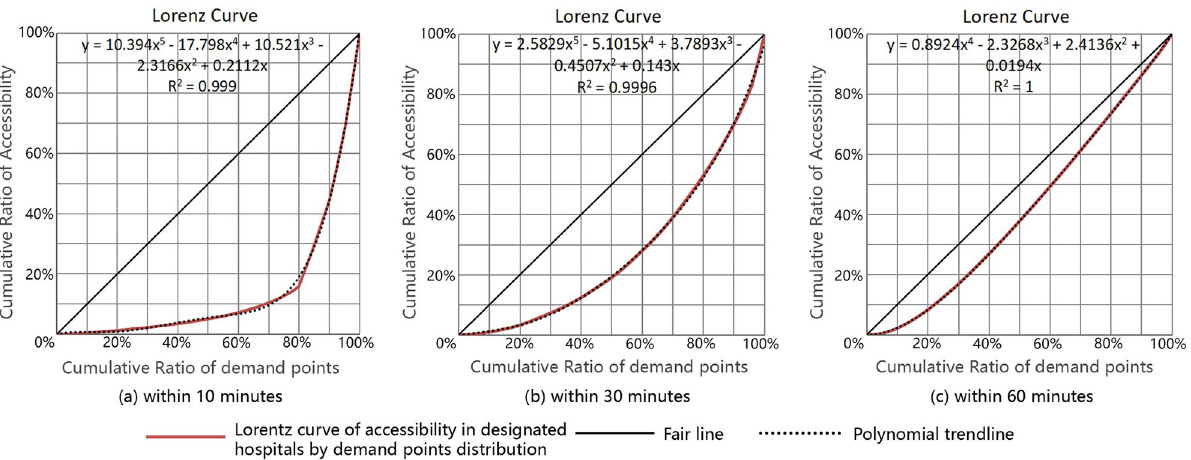
Fig 10. Lorentz curve of accessibility to designated hospitals by demand point distribution. (a)Within 10 minutes, (b) Within 30 minutes, (c) Within 60 minutes.